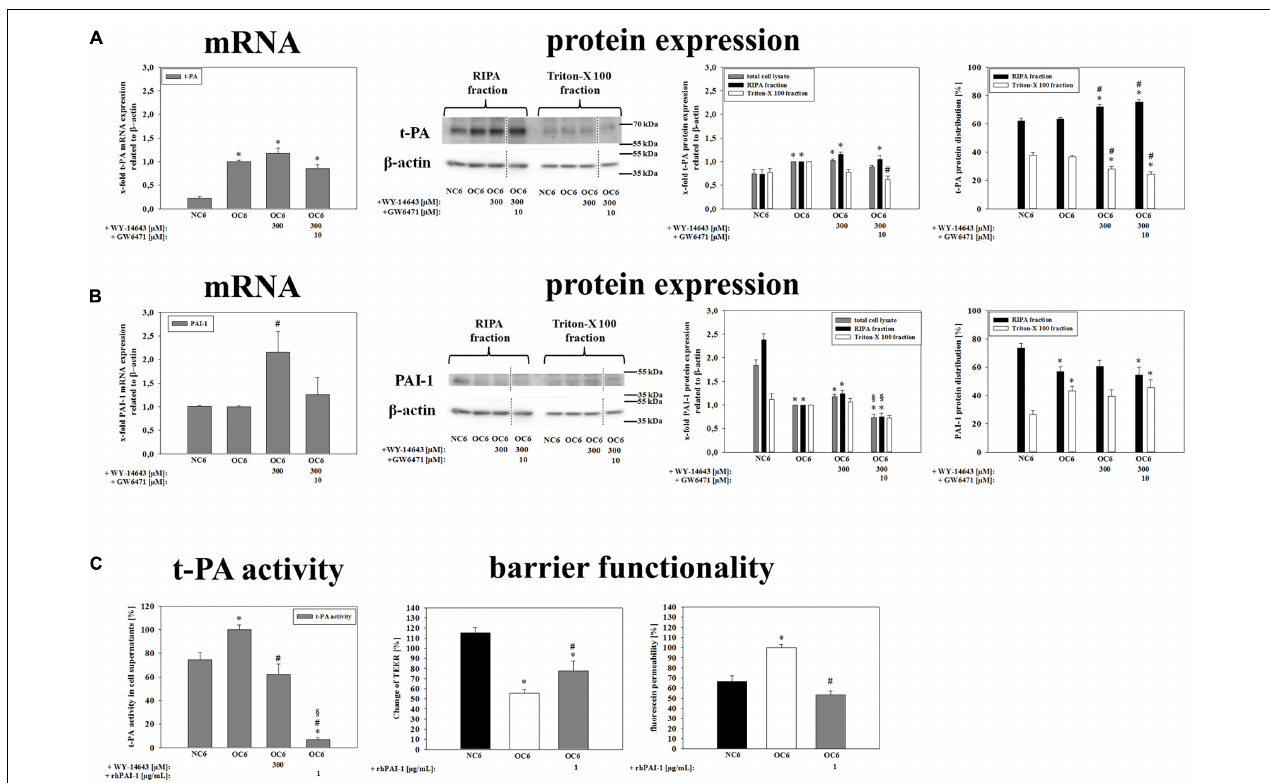
FIGURE 5 | Influence of WY-14643 on t-PA and PAI-1 expression and activity in the blood-brain barrier (BBB) in vitro ischemia model. OC6 treatment of cerebENDs accords to 4 h OGD treatment with medium supernatants derived from 4 h OGD-treated C6 cells, whereas NC6 treatment means cerebEND cells incubated for 4 h under normoxic conditions with medium supernatants of 4 h normoxic treated C6 cells. Results on mRNA as well as protein expression of t-PA (A) and PAI-1 (B) of cerebEND cells after OC6 treatment were displayed. Effects of WY-14643 on t-PA activity and of rhPAI-1 on barrier functionality were shown in (C) . Densitometric analyzed protein expression of total cell lysates were compared to RIPA and triton-X 100 fractions. Protein distributions [%] between cytoskeleton (RIPA) and membrane enriched fractions (triton-X 100) were presented. Values were related to β -actin and according representative western blot images are depicted. Dotted lines indicated cuts of images of the same blot due to presentation reasons of selected bands. Statistical significance was labeled with ∗ vs. NC6, # vs. OC6 and § vs. OC6 + WY ( p < 0.05). Data are presented as means ± SEM (mRNA: n = 4–8, protein expression: n = 3–6, t-PA activity: n = 8–10, and barrier functionality: n =